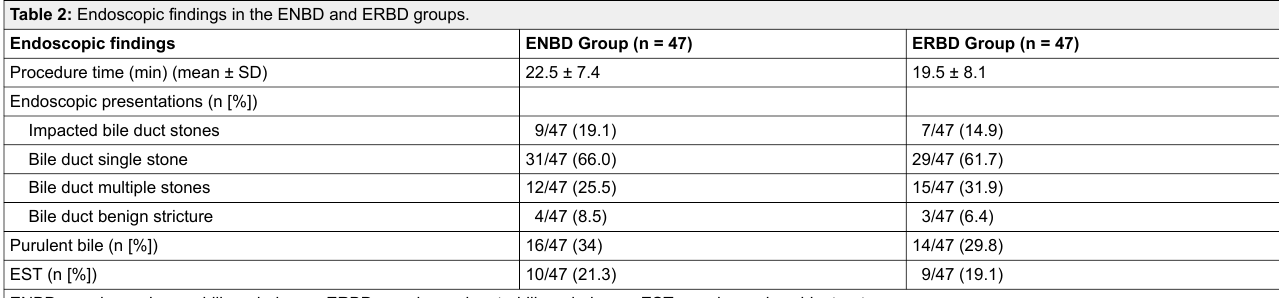
Table 2: Endoscopic findings in the ENBD and ERBD groups. Endoscopic